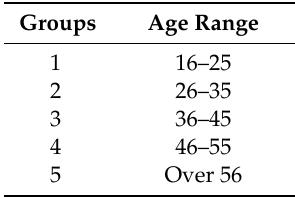
Table 9. Age ranges of the